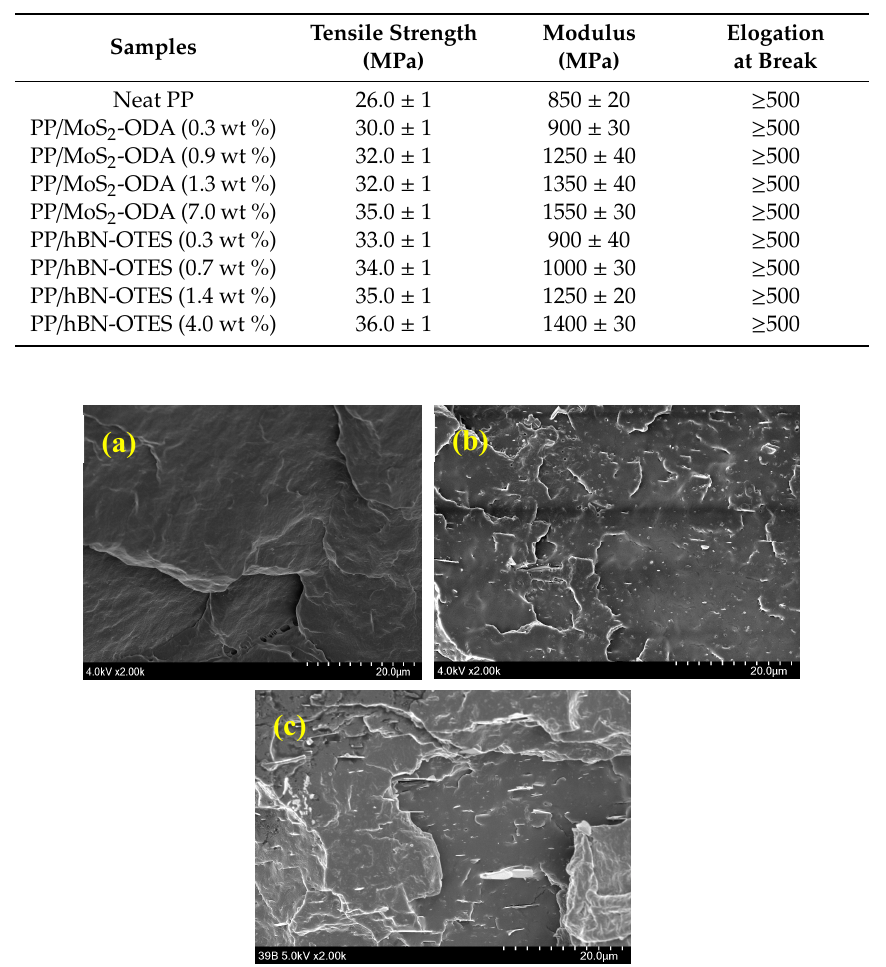
Figure 7. SEM images of the fractured surfaces of ( a ) neat PP ( b ) PP / MoS 2 -ODA (7.0 wt %) and ( c ) PP / hBN-OTES (4.0 wt %).